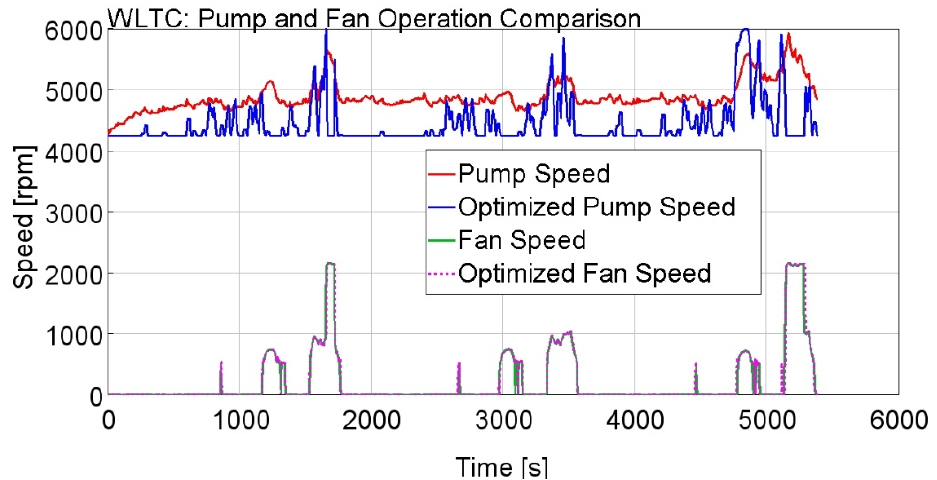
Figure 16. Control strategy comparison for dual IDM on WLTC driving cycle: coolant pump speed (top); radiator fan speed (bottom).